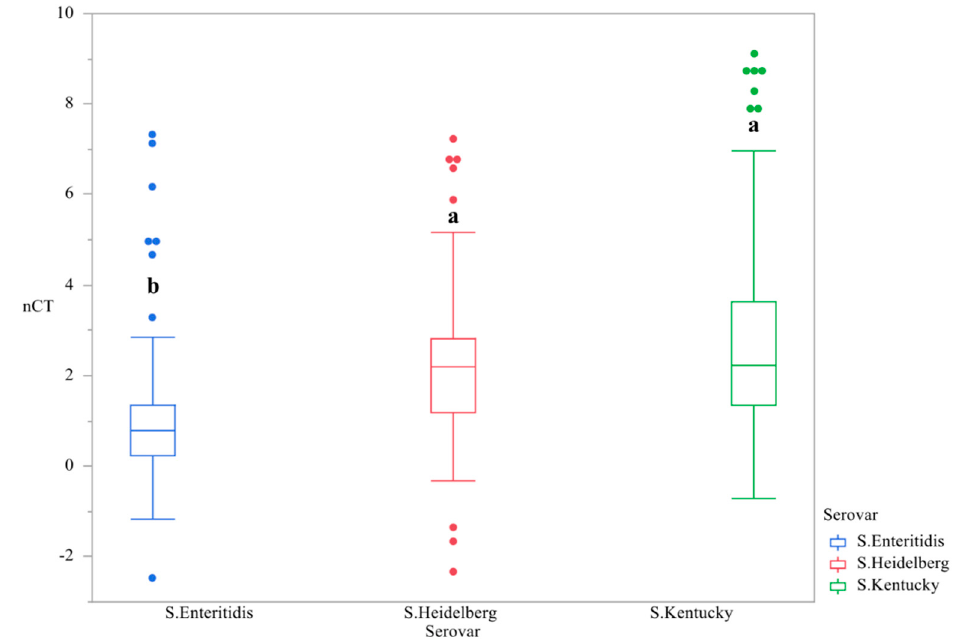
Figure 2. Differences in expression of the gene csgD between serovars 1,2 . qRT-PCR was performed on total RNA isolated from bacterial cultures of Salmonella as pellicles were being formed over a 4-day time period. 1 N = 270, n = 90, p < 0.0001, Individual SEM was 0.170, 0.184, 0.253 for S. Enteritidis, Heidelberg, and Kentucky. 2 Means with different superscripts are considered significantly different (a–b). Table 1. Changes in expression of the gene CsgD from planktonic cells used to form Salmonella pellicles over a 4-day time period 1,2 .